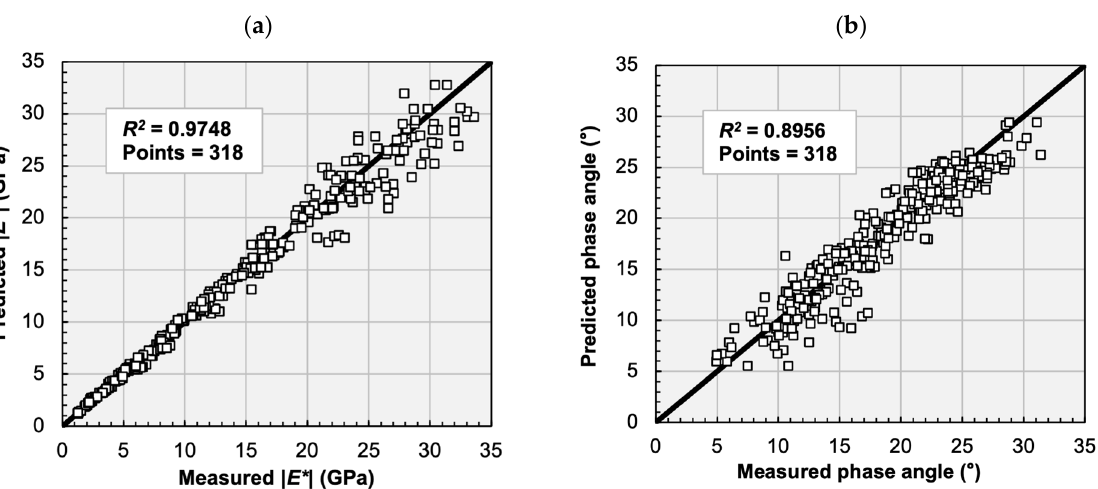
Figure 4. Comparison of predicted and measured values of dynamic moduli ( a ) and phase angles ( b ) in case of 5 asphalt mixture types (318 data points).